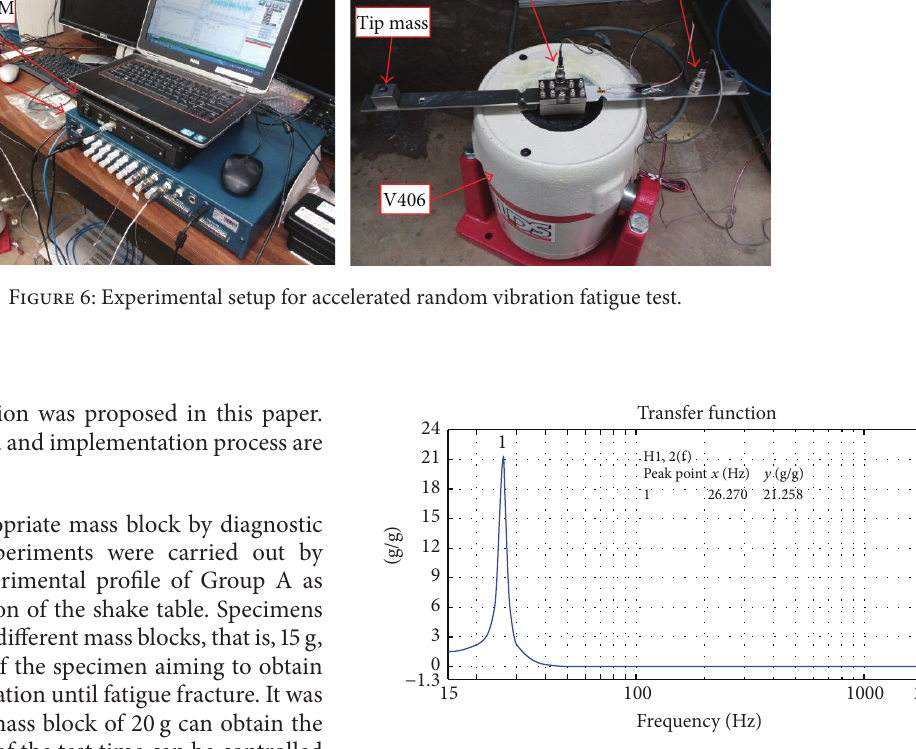
Figure 7: Frequency response function from sweep sine